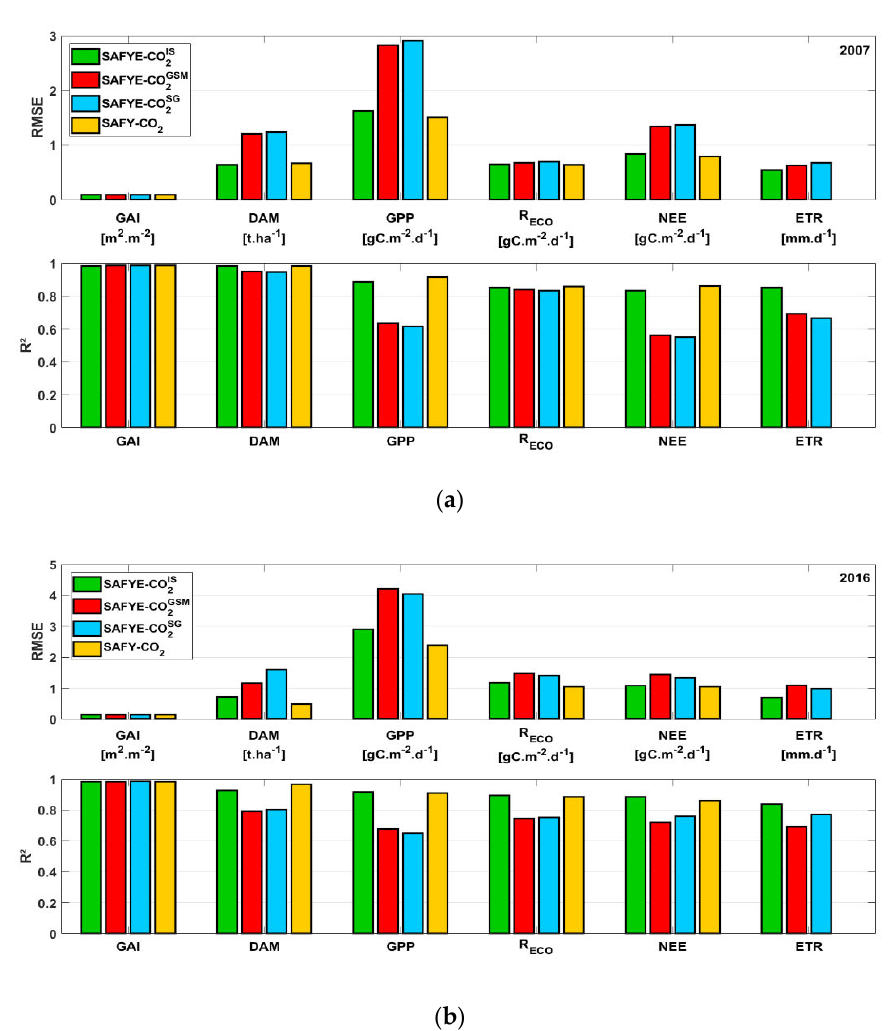
Figure 6. RMSE and R 2 values for the main model’s output for CY ‐ 07 (a) and CY ‐ 16 (b) at FR ‐ Aur via SAFY ‐ CO 2 (orange bars) or SAFYE ‐ CO 2 run with in situ soil data (SAFYE ‐ CO 2IS , green bars), GlobalSoilMap data (SAFYE ‐ CO 2GSM , red bars), and SoilGrids data (SAFYE ‐ CO 2SG , blue bars).